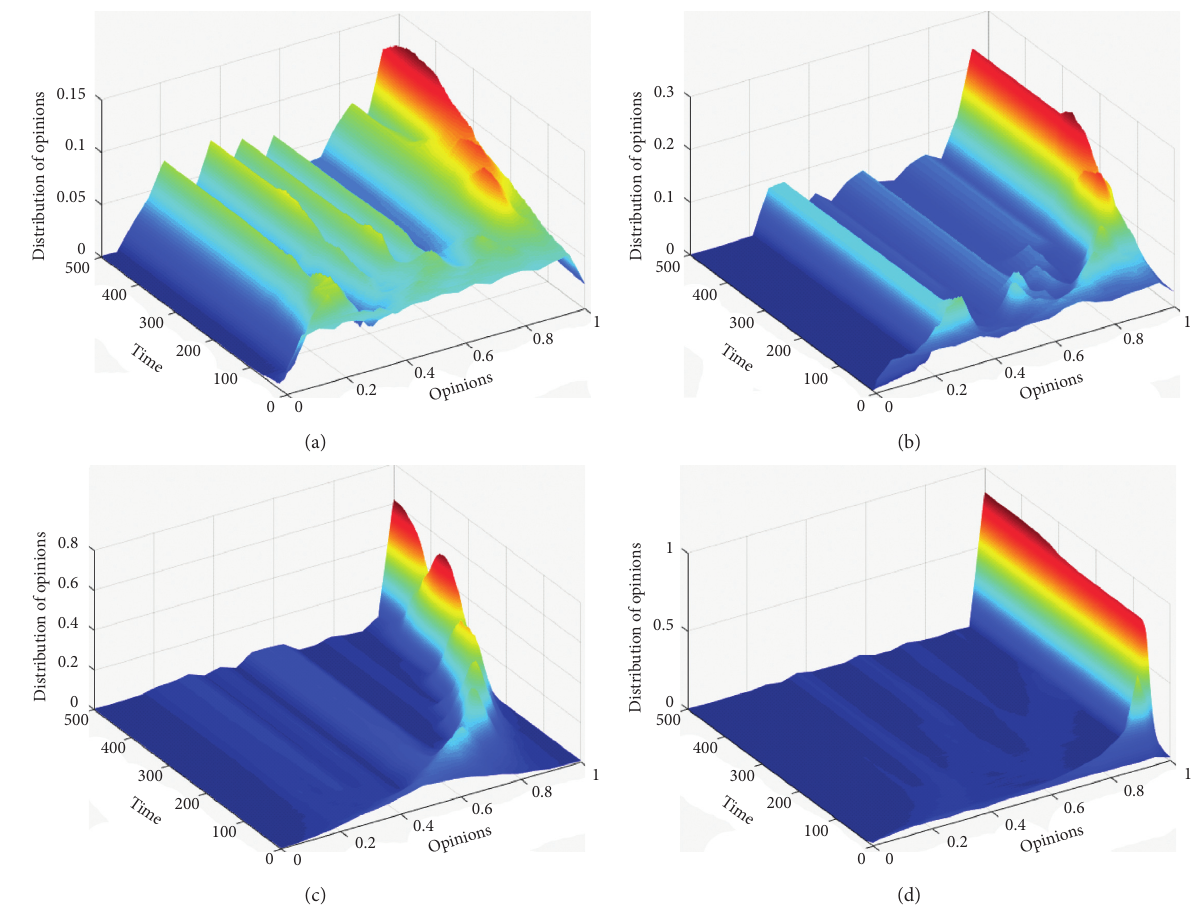
Figure 4: Group opinion distribution evolution when x � 2. Compared with the conditions when x � 1/2 and x � 1, the value of d when group polarization is formed under x � 2. (a) d m � 0 . 1. (b) d m � 0 . 2. (c) d m � 0 . 3. (d) d m � 0 .